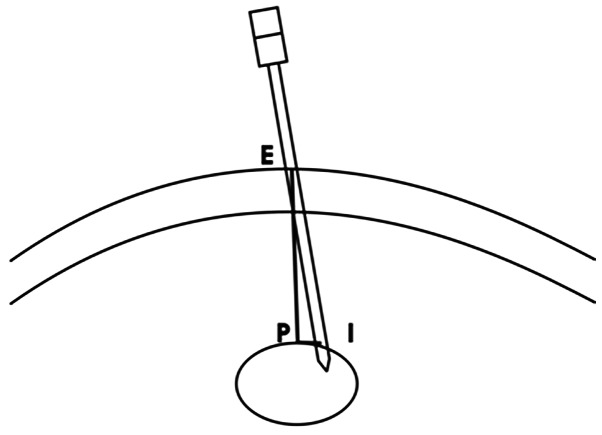
Diagram of the PCNP measurement protocol. E, skin entry site; P, predefined sampling position (PSP); EP, the most appropriate route. EI is the line in which the coaxial needle lies. PI is the line perpendicular to EP. I is the intersection of PI and EI. PCNP, precise coxial needle placement.